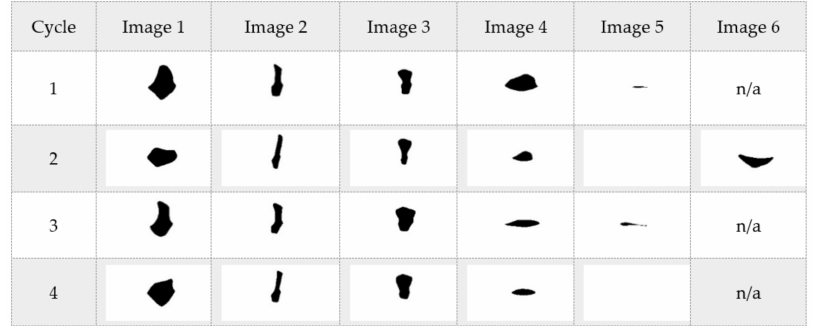
Figure 11. The repeated oscillatory pattern over 21 images (over 4 image cycles) of Sample 2 (Low) openings between 21–23 s of test. Images 5282 to 5302 of 150,010 processed to display only colours 0 and 255. Threshold colour for opening is 34 with averaging 1.